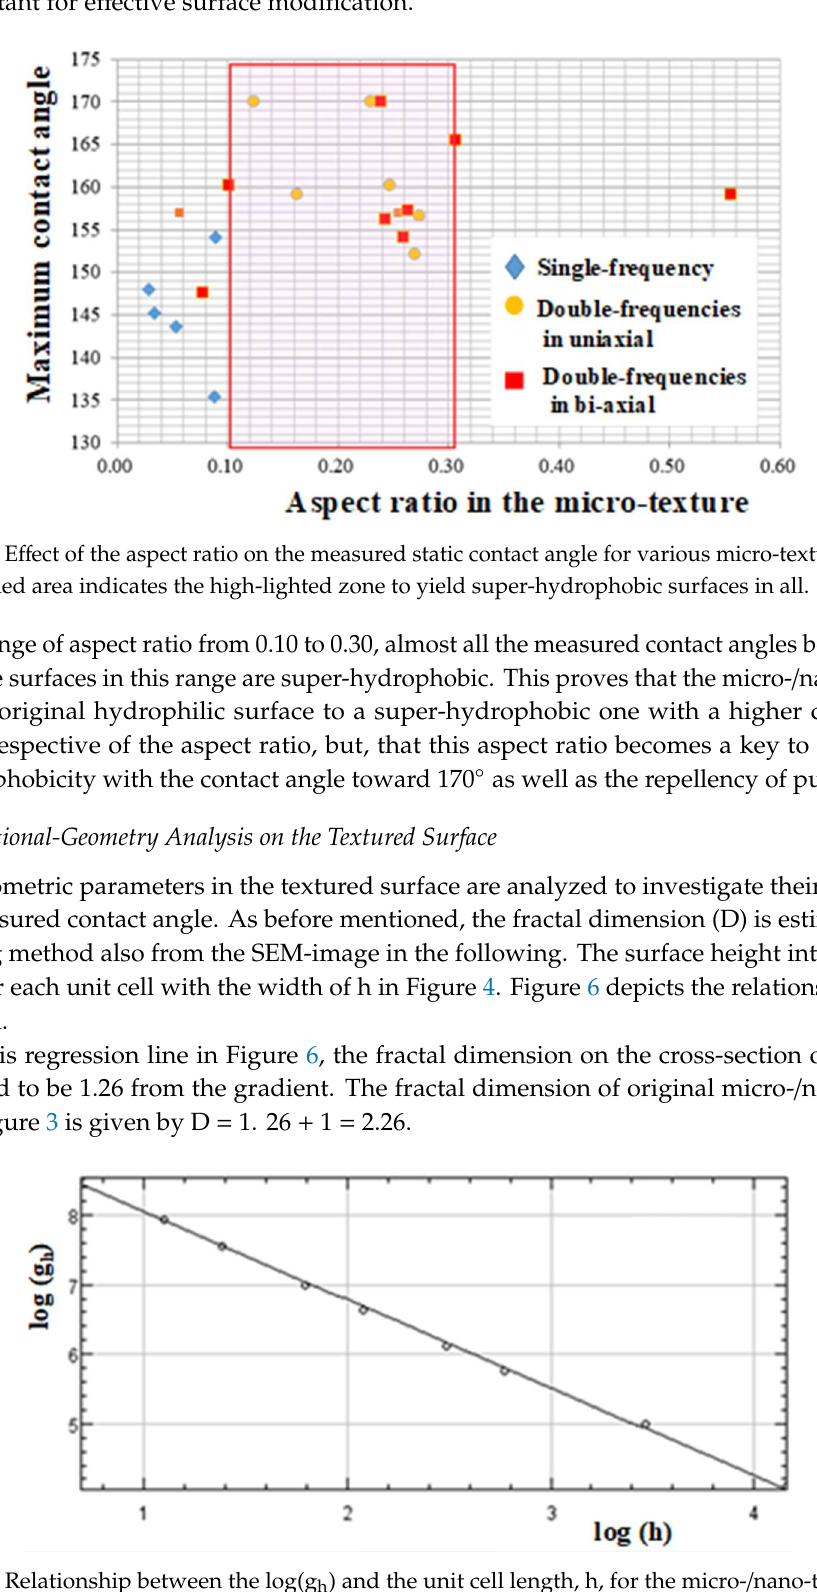
Figure 6. Relationship between the log(g h ) and the unit cell length, h, for the micro-/nano-texture in Figure 4, after the box-counting Figure 4, after the box-counting method.